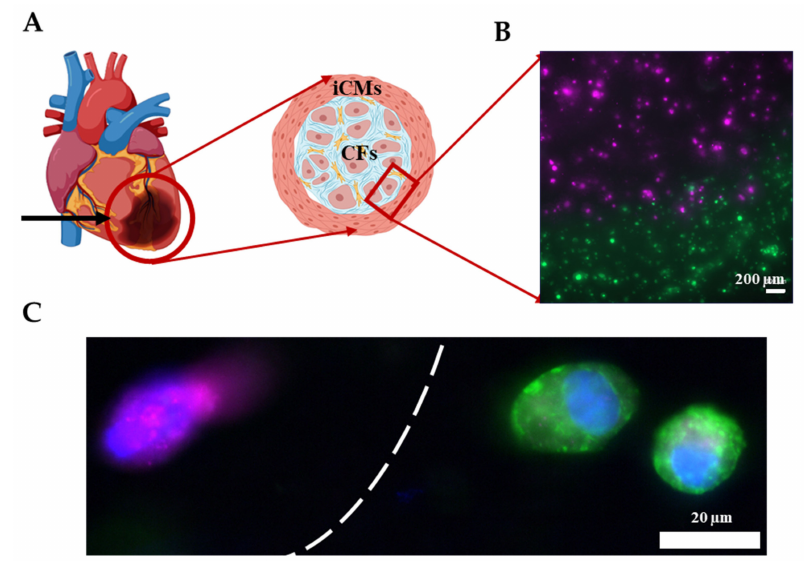
Figure 7. Printing the infarct region. ( A ) Schematic showing the infarct region model and correspond- ing cells. ( B ) Image showing the successful printing of the infarct region with iCMs (green) and hCFs (magenta). ( C ) Immunostaining of iCMs for sarcomeric alpha-actinin (green) and hCFs for Vimentin (magenta). Cell nuclei are stained with DAPI